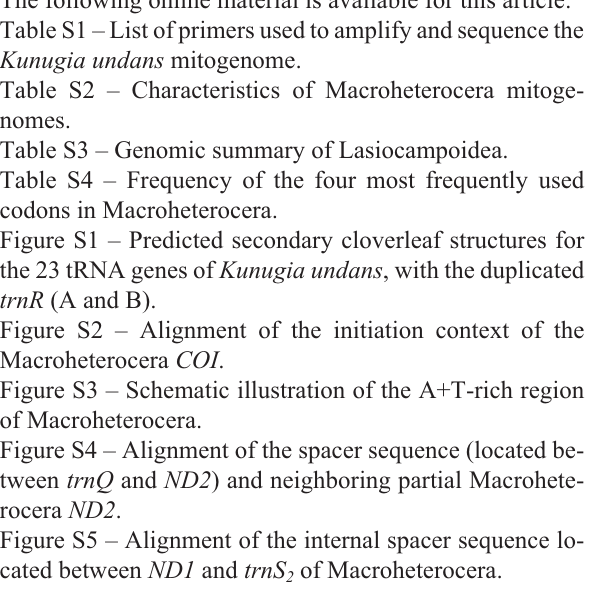
Figure S1 – Predicted secondary cloverleaf structures for the 23 tRNA genes of Kunugia undans , with the duplicated trnR (A and B). Figure S2 – Alignment of the initiation context of the Macroheterocera COI . Figure S3 – Schematic illustration of the A+T-rich region of Macroheterocera. Figure S4 – Alignment of the spacer sequence (located be- tween trnQ and ND2 ) and neighboring partial Macrohete- rocera ND2 . Figure S5 – Alignment of the internal spacer sequence lo - cated between ND1 and trnS of 2